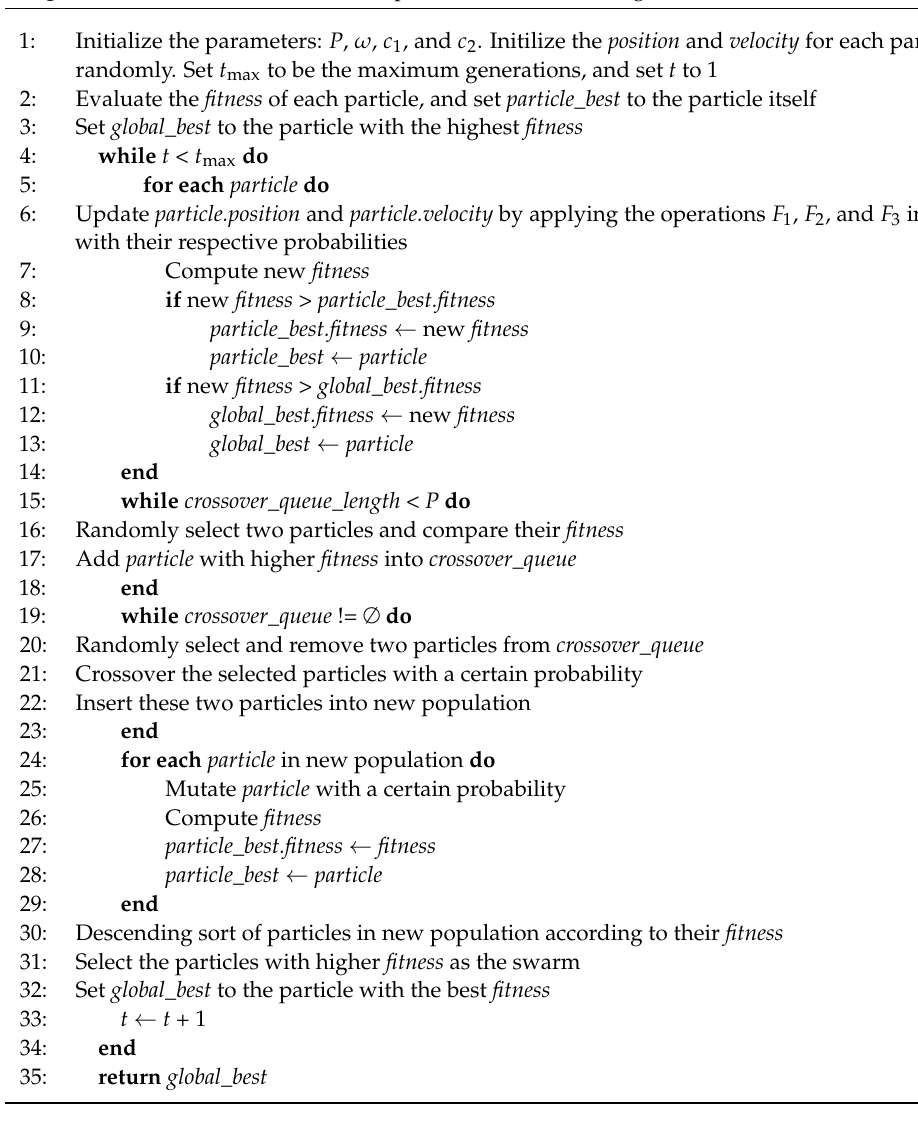
Algorithm 3: Discrete PSO with GA operators (DPSO_GA)